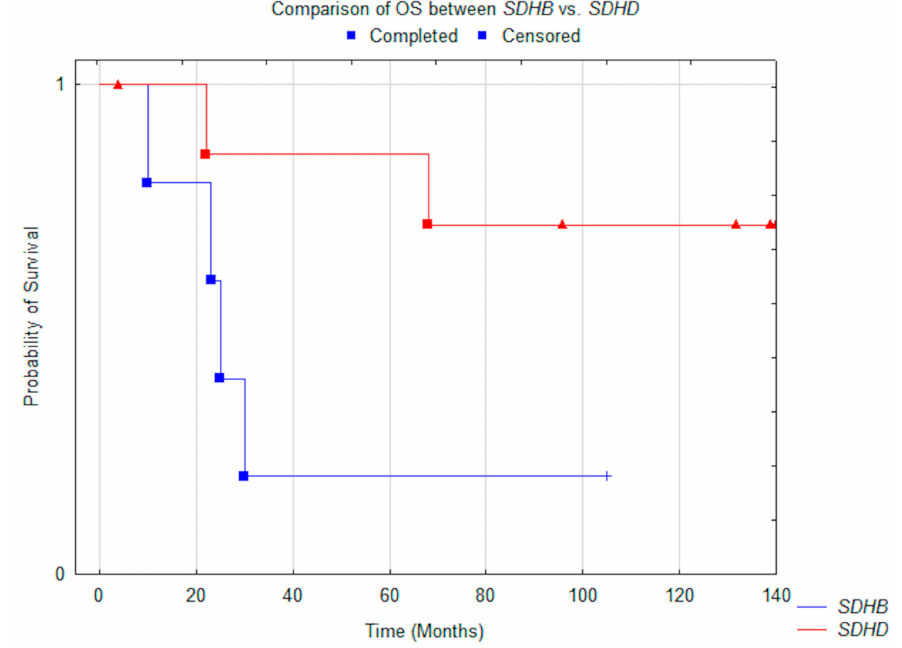
Figure 2. Comparison of median OS between SDHD ( n = 8) vs. SDHB ( n = 5) patients ( p =